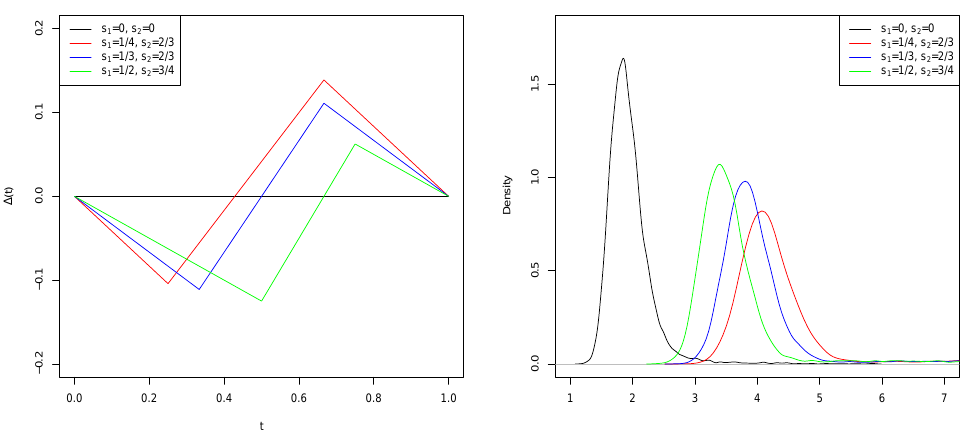
Figure 3. Functions ∆ ∗